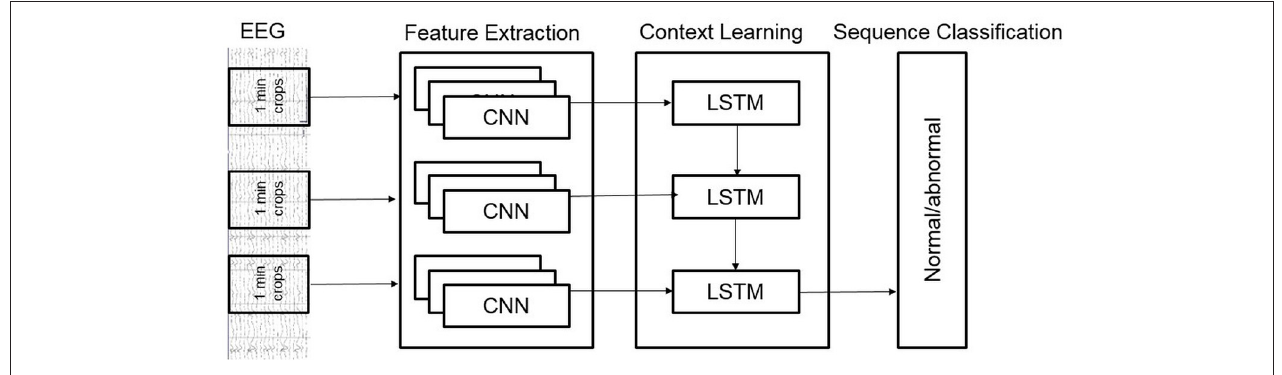
FIGURE 4 | Architecture of our hybrid model.